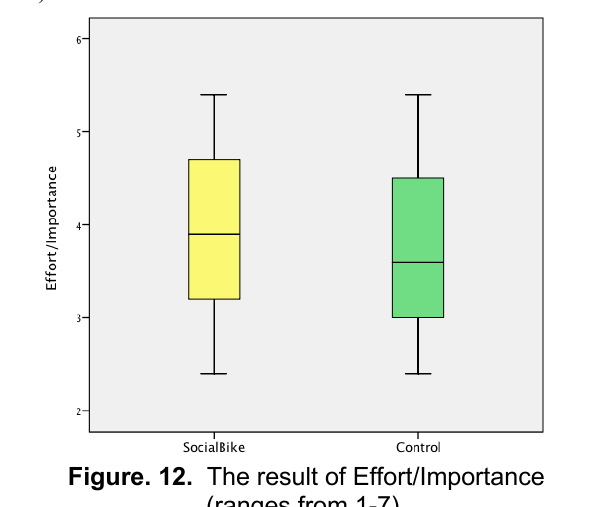
Figure. 12. The result of Effort/Importance (ranges from 1-7).